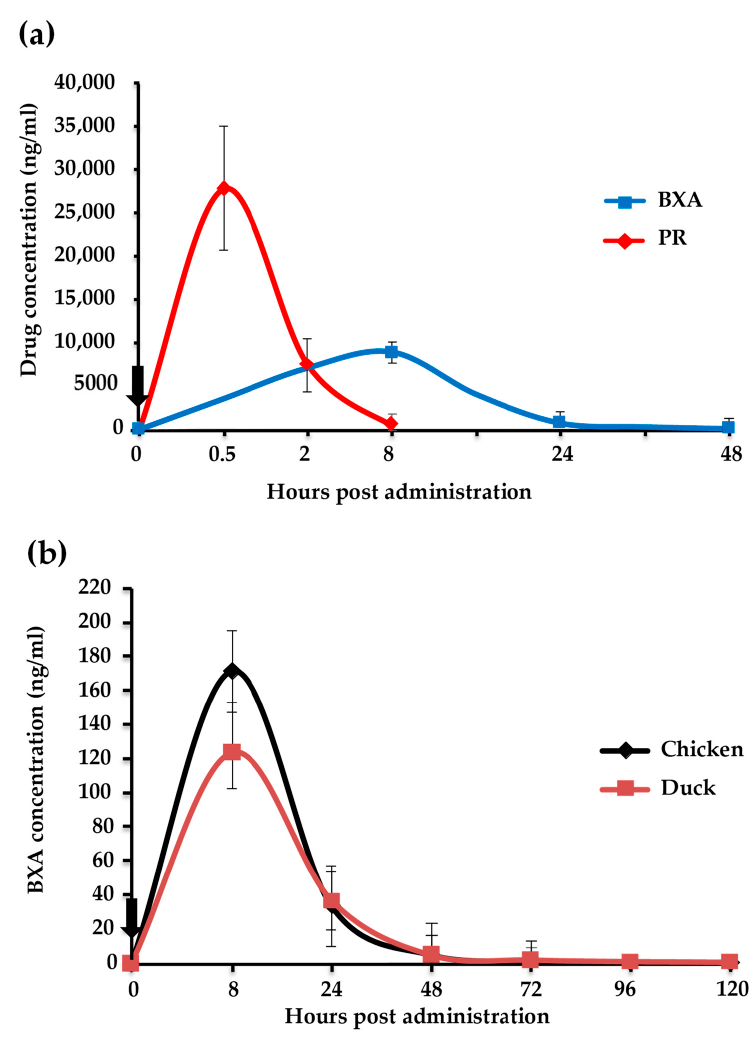
Figure 4. Drug concentration in the blood of chickens and ducks. ( a ) Three chickens per group received 20 mg / kg of BXM or PR. The blood was collected at 0, 8, 24, and 48 h post-administration (hpa) for BXM and at 0, 0.5, 2, and 8 hpa for PR. ( b ) BXA plasma concentration in chickens and ducks administered with 2.5 mg / kg of BXM. Blood was collected at 0, 8, 24, 48, 72, 96, and 120 hpa. The curve shows the mean plasma concentration of BXA and PR at di ff erent time points. The bar indicates the standard deviation ( n = 3). The black vertical arrow indicates the drug administration